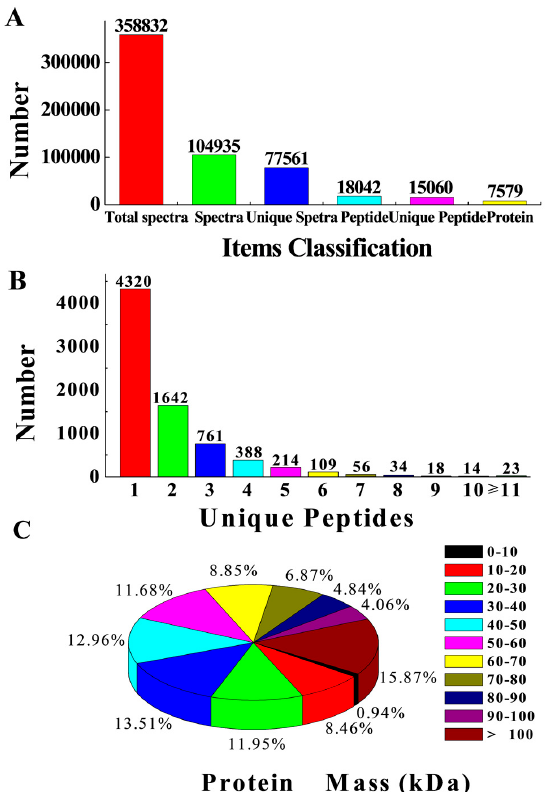
Figure 3. Results of the isobaric tag for a relative and absolute quantitation (iTRAQ) liquid chromatography/tandem mass spectrometry analysis of ‘T337’ basal cuttings with IBA treatment and control. ( A ) Identified proteins, Unique peptide: A protein-specific peptide; Unique spectra: spectra that matched unique peptides; ( B ) Number of unique peptides that were matched to